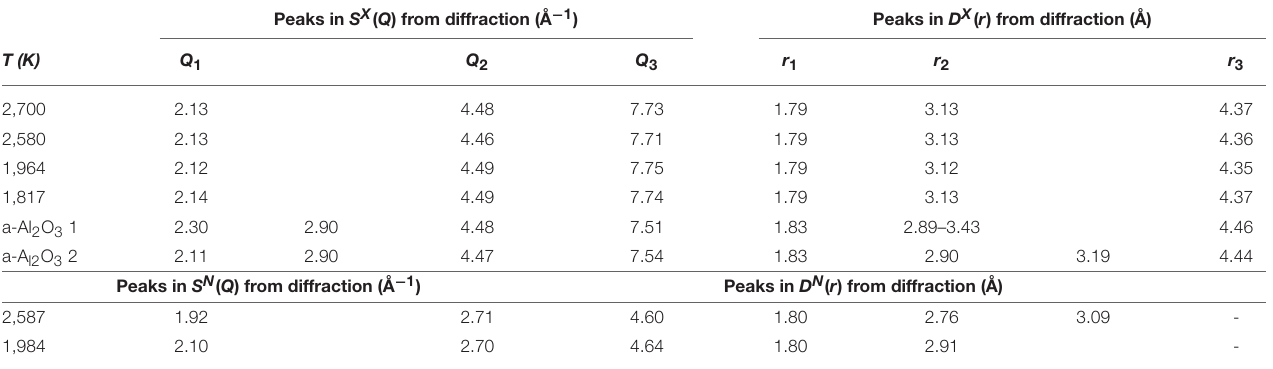
TABLE 1 | Peak positions in both reciprocal and real space from x-ray and neutron diffraction on supercooled liquid alumina. Peaks in S X ( Q ) from diffraction (Å − 1 )